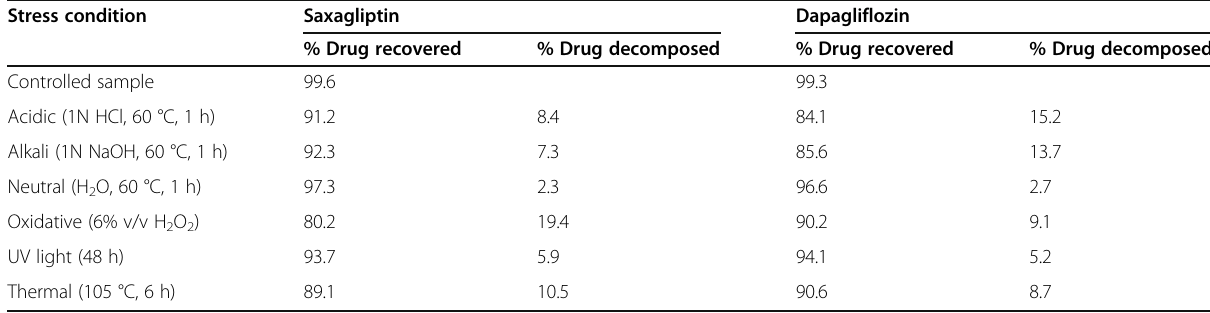
Table 5 Results of stress degradation studies Stress